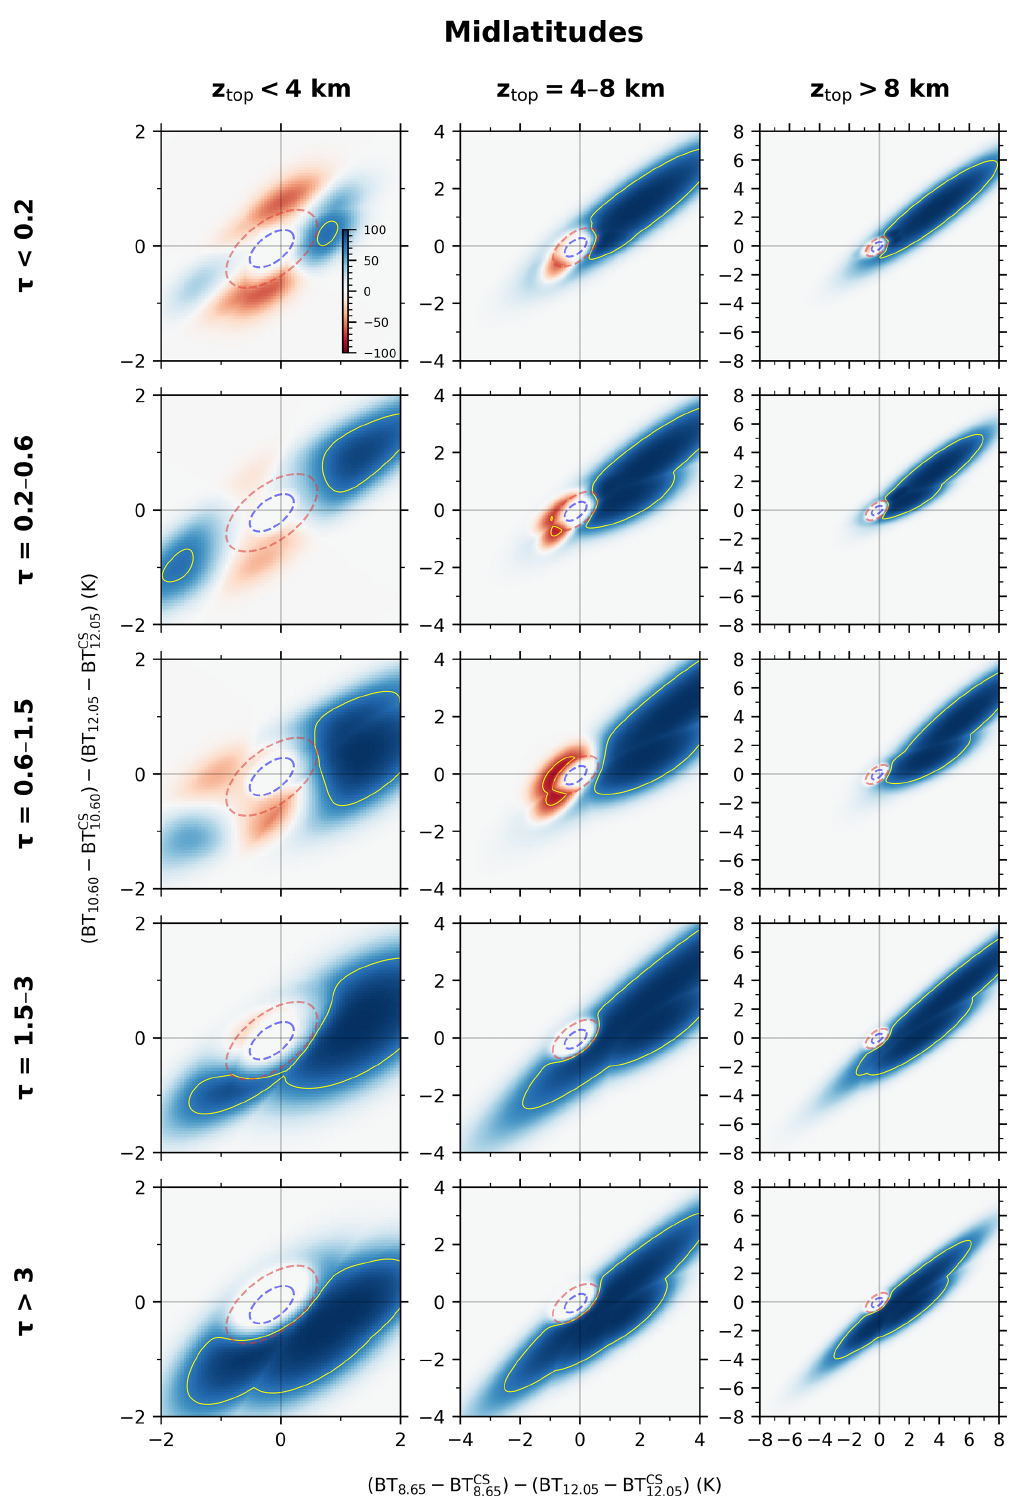
Figure 11. As Fig. 10 for the